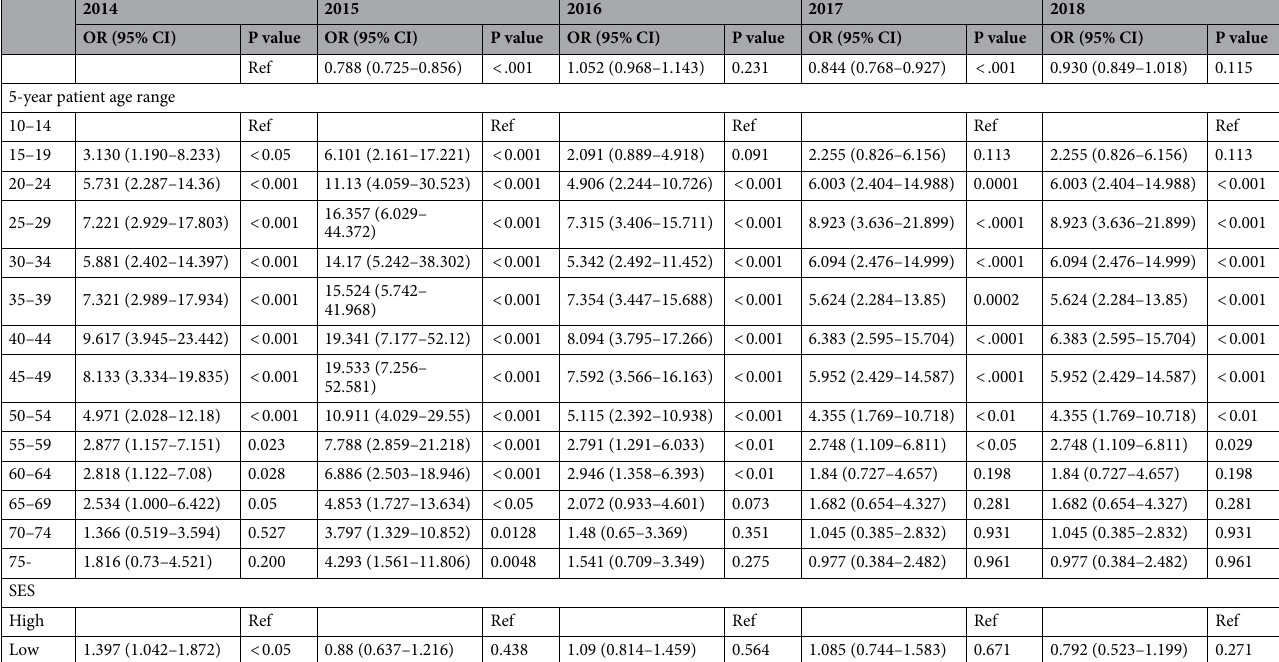
Table 4. Multivariate logistic regression analysis of the risk factors of borderline ovarian tumors. OR odds ratio, SES socioeconomic status, OR odds ratio, CI confidence interval.